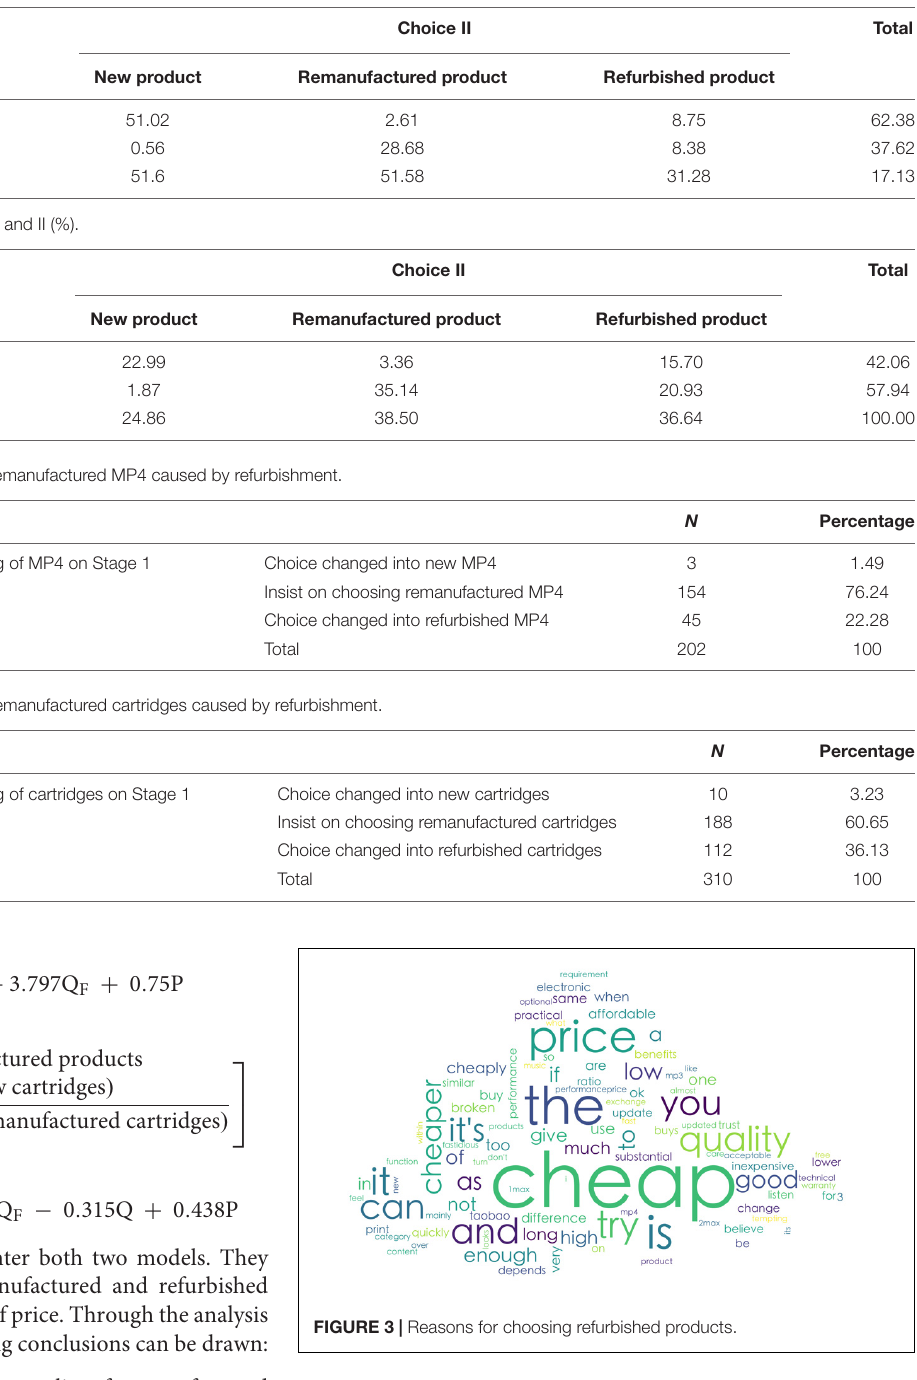
TABLE 4a | Consumers’ choice of MP4 I and II (%).